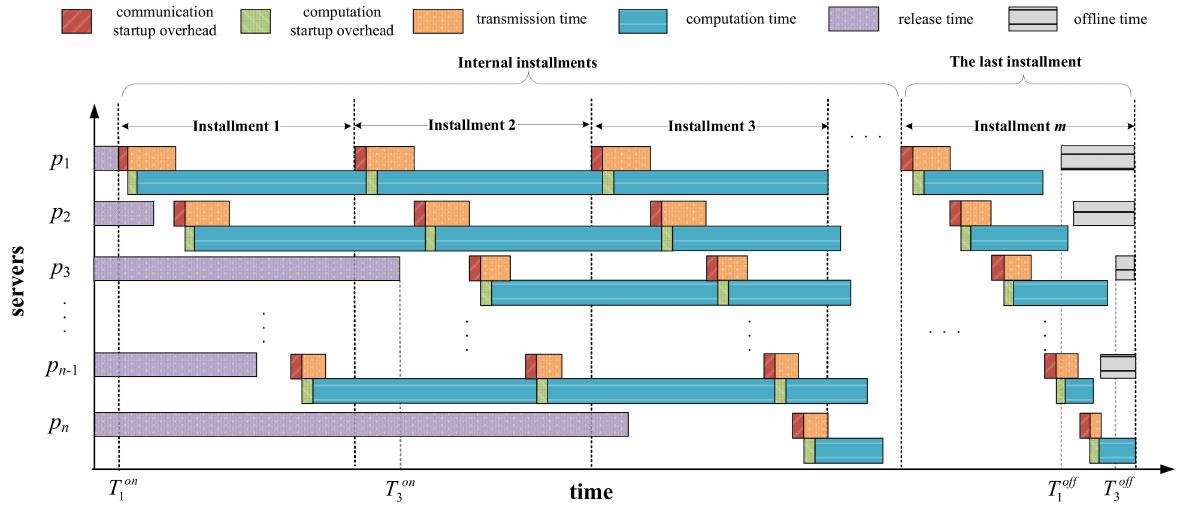
Figure 2. Multi-installment scheduling with server available